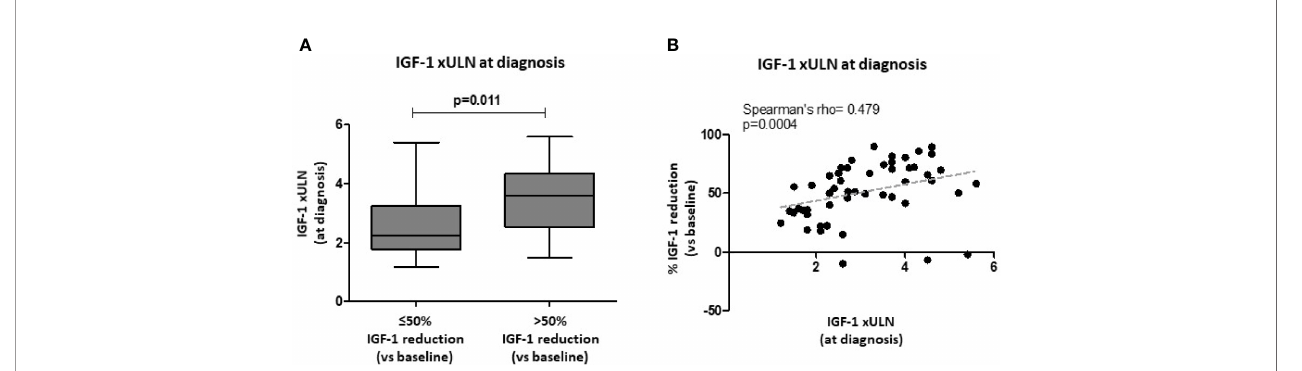
FIGURE 2 | Biochemical response after fi rst-line SRL treatment (6 months) with respect to baseline IGF-1 values. Age-adjusted IGF-1 values (xULN) were higher in patients achieving a >50% IGF-1 reduction after SRL treatment, compared to those subjects with a lower response rate (A) . A direct signi fi cant correlation was found between IGF-1 xULN levels at diagnosis and the % IGF-1 reduction observed after 6-month therapy with fi st-generation SRLs (B) . SRLs, somatostatin receptor ligands; ULN, upper limit of